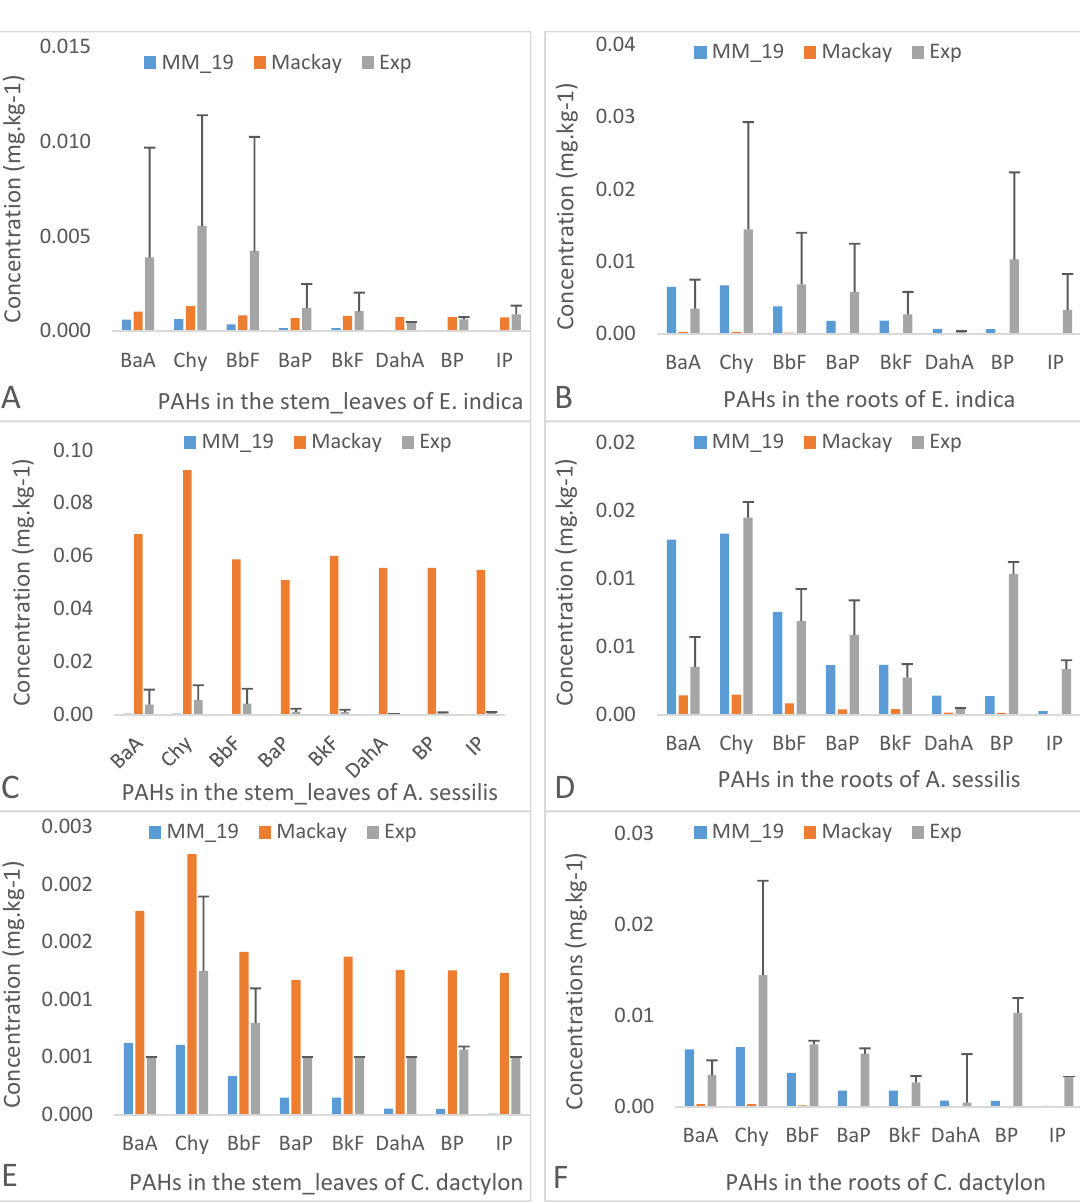
Figure 3. Improved model (MM_19), Mackay_97 model (Mackay) and experimental (Exp) concentrations of the 8 heavier PAHs in the different parts of the 3 plant species. Stem_leaves (A) and Roots (B) of E. indica ; Stem_leaves (C) and Roots (D) of A. sessilis ; Stem_leaves (E) and Roots (F) of C. dactylon . PAHs abbreviations are: Benzo(a)anthracene (BaA), Chrysene (Chy), Benzo(b)fluoranthene (BbF), Benzo(k)fluoranthene (BkF), Benzo(a)pyrene (BaP), Dibenzo(ah)anthracene (DahA), Benzo(ghi)perylene (BP) and Indeno(1,2,3-cd)pyrene (IP).